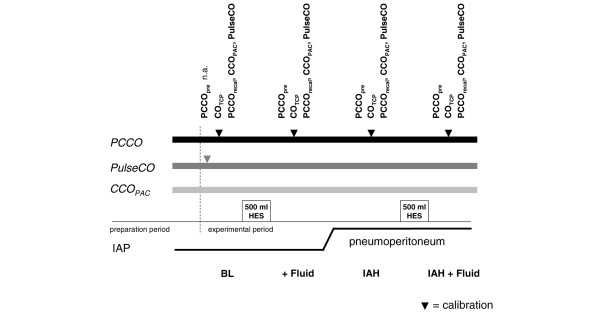
Experimental protocol. The methods used were continuous cardiac output by pulse contour analysis (PCCO; PiCCO system), continuous cardiac output by pulse power analysis (PulseCO; LiDCO system), continuous cardiac output by pulmonary artery catheter thermodilution (CCOPAC), and bolus transcardiopulmonary thermodilution cardiac output (COTCP). PCCO was measured before recalibration (PCCOpre) and after recalibration (PCCOrecal) by COTCP. Experimental steps: BL, baseline; + Fluid, fluid loading; IAH, intra-abdominal hypertension; IAH + Fluid, second fluid load at IAH. HES, hydroxyl-ethyl starch 6%; IAP, intra-abdominal pressure; n.a., not applicable.